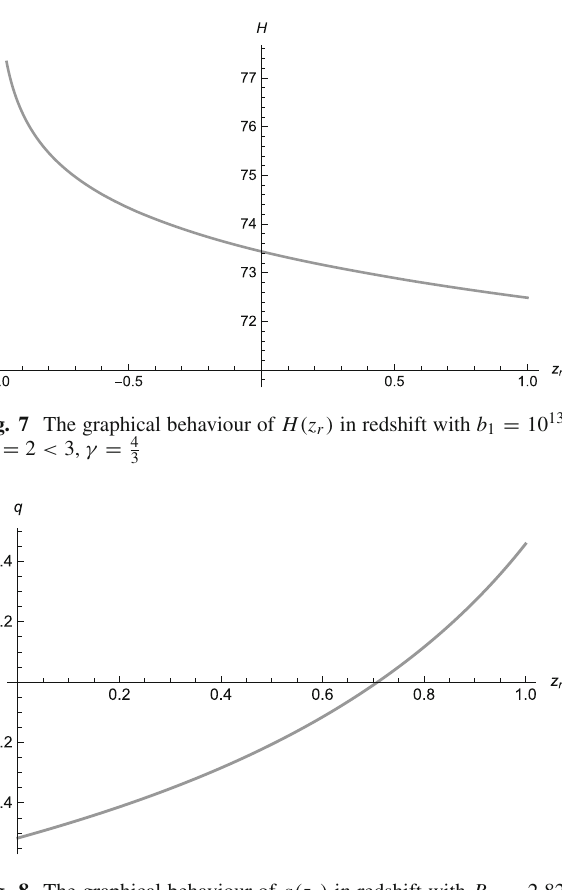
Fig. 8 The graphical behaviour of q ( z r ) in redshift with B 1 = 2 . 82, γ =